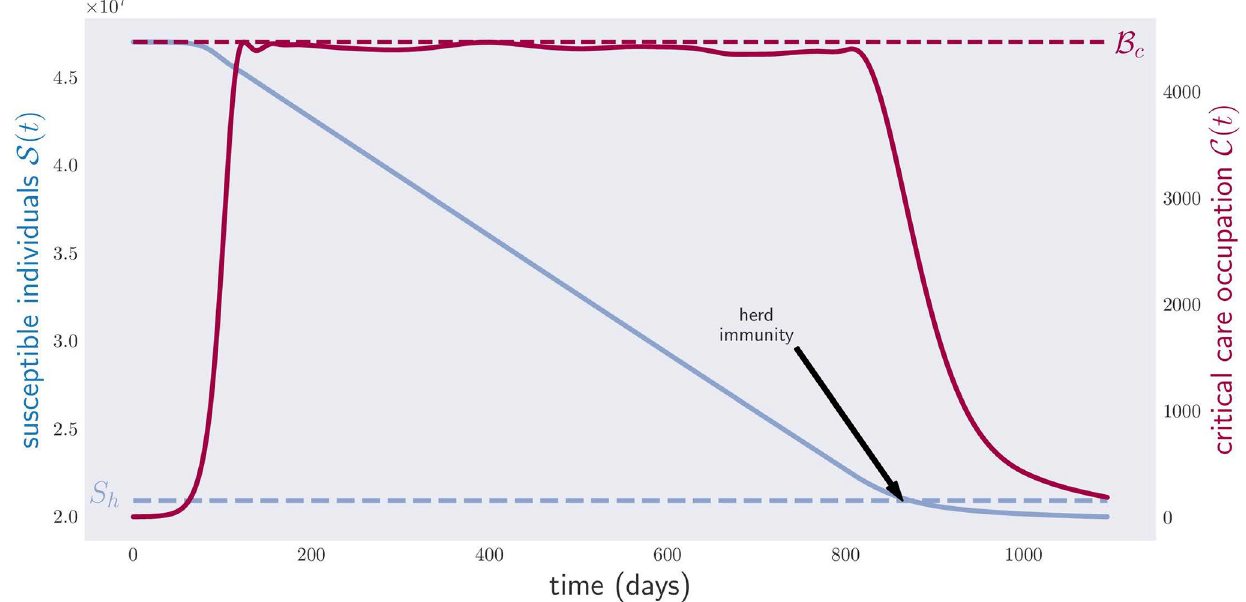
Fig 3. Occupation of critical care beds (red) and population of susceptible individuals (blue) for a period of three years. The blue line corresponds to the level of susceptibles guaranteeing herd immunity over the whole year.